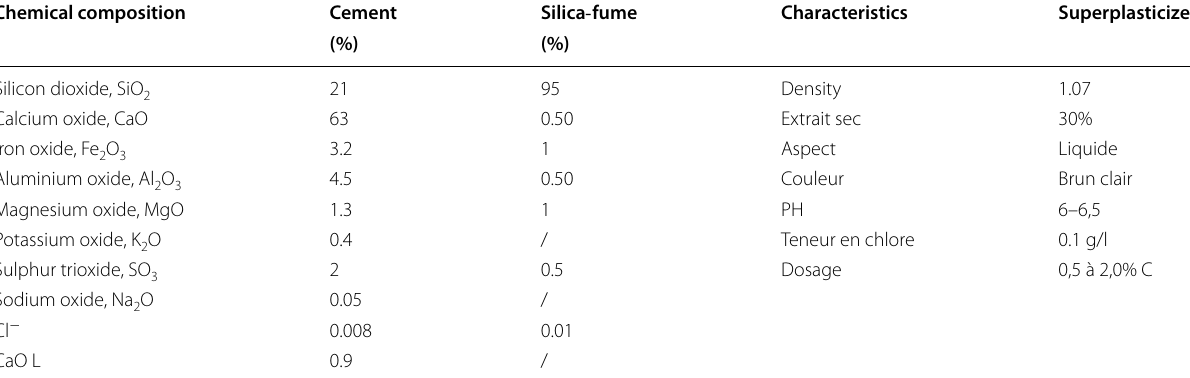
Table 1 Chemical compositions of Portland CEM II 42.5, silica fume and admixture.